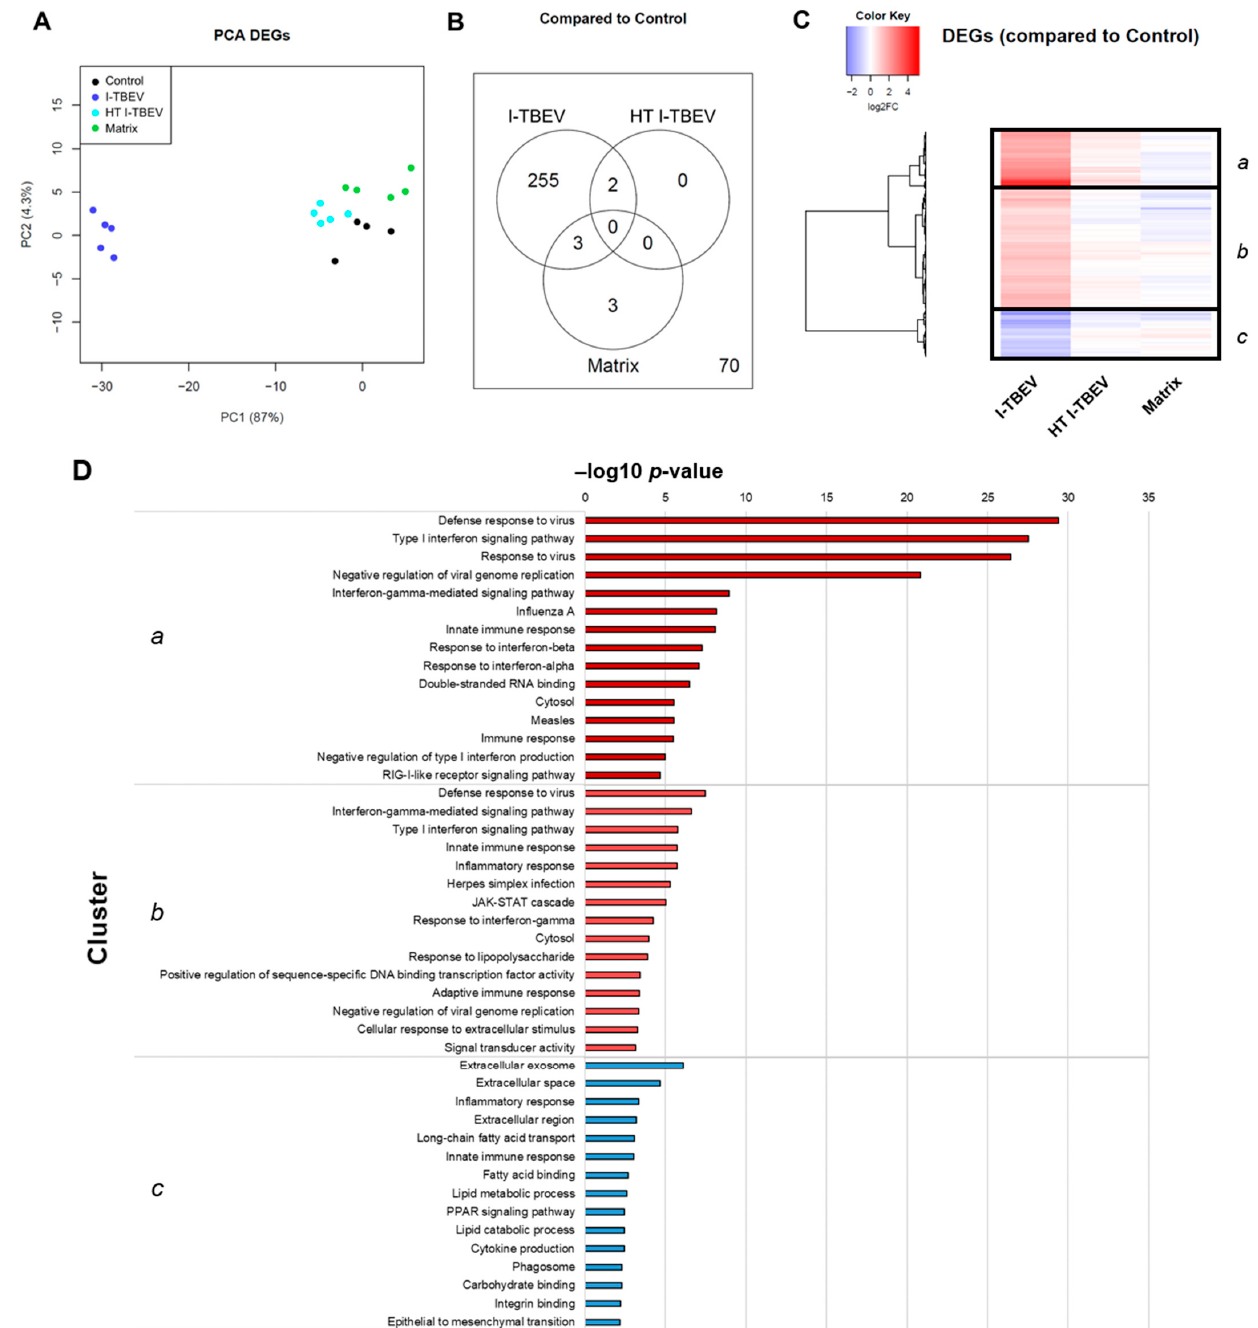
Figure 1. Transcriptional analysis of PBMCs stimulated with conforming and non-conforming I-TBEV (Analysis 1). PBMCs from a healthy donor were stimulated for 24 h with inactivated TBEV (I-TBEV), heat-treated I-TBEV (HT I-TBEV) or sucrose matrix at a concentration of 0.24 μ g/mL (or an equivalent volume for the matrix). After treatment, the cells were lysed and processed for RNA sequencing. ( A ) Principal component analysis based on differentially expressed genes (DEGs) showing relative (dis)similarity for the samples. ( B ) Venn diagram showing DEGs with a fold change (FC) > 2 in expression between the different treatment groups and the control group. Outside the circles, the number of DEGs with a FC < 2. ( C ) Heatmap representing the fold change of DEGs in the three treatment groups, normalized to the control group (set as FC = 1). ( D ) Top 15 GO terms and KEGG pathways identified in each cluster following functional enrichment. The bar shows the –log10 of the raw p -value.